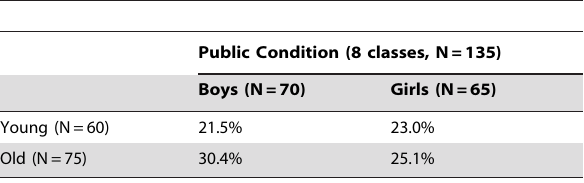
Table 1. Distribution of age groups and gender in Public Condition (in %).